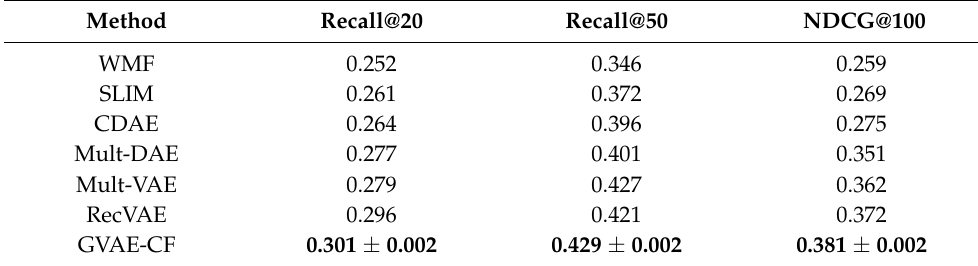
Table 3. Evaluation scores for GVAE-CF and baseline models on